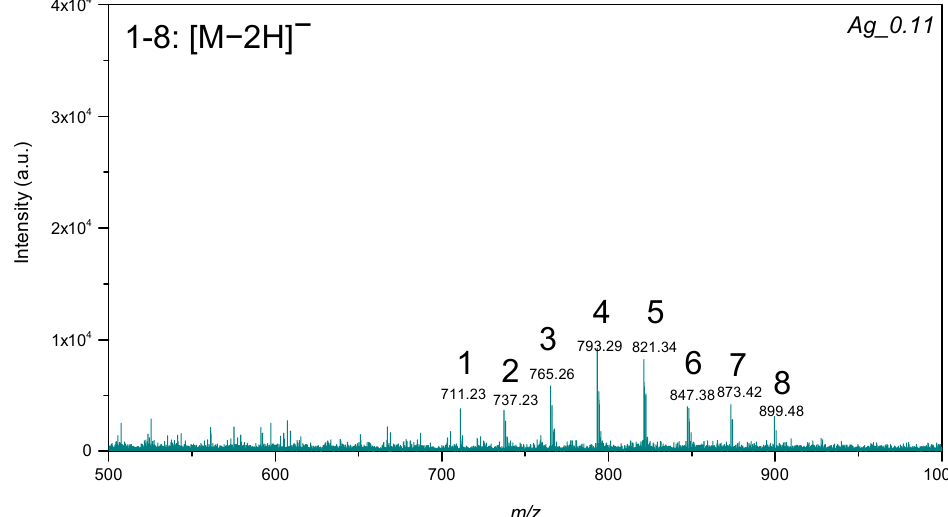
Figure 4. LDI-MS spectra of the standard mixture of phosphatidylethanolamines, where 1—17:0- 14-1 PE (25 µg/mL); 2—17:0-16:1 PE (50 µg/mL); 3—17:0-18:1 PE (75 µg/mL); 4—17:0-20:3 PE (50 µg/mL); 5—17:0-22:4 PE (25 µg/mL), for the LDI plates AgPs0.02, AgPs0.03, AgPs0.11 and AgPs0.2. Triacylglycerols (TGs) were detected for the plate Ag0.11 in negative mode (Figure 5). All plates showed signals assigned to [M-2H] (cid:2879) for all triacylglycerols. Only the TG with mass 929.84 Da was not detected in negative mode.